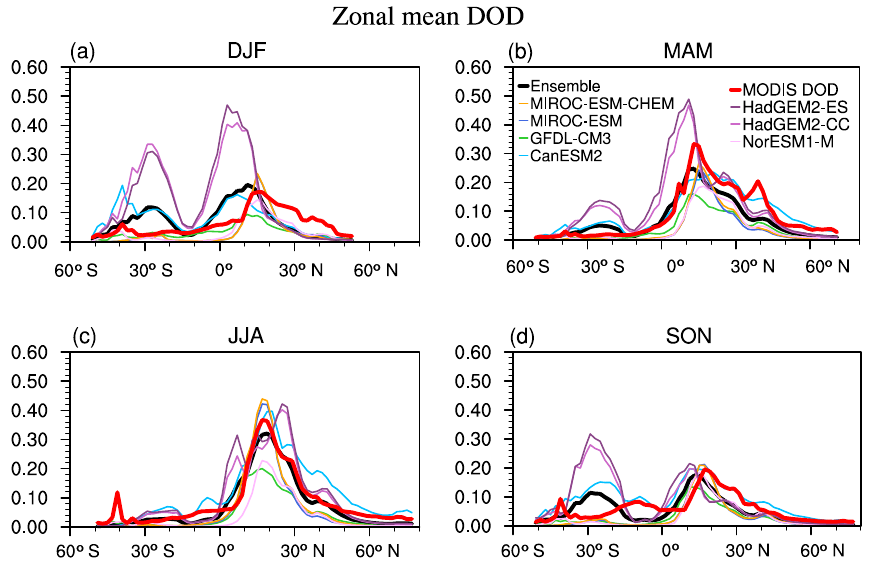
Figure 2. Zonal mean DOD from MODIS (thick red), CMIP5 multi-model mean (thick black), and each individual model (other colorful